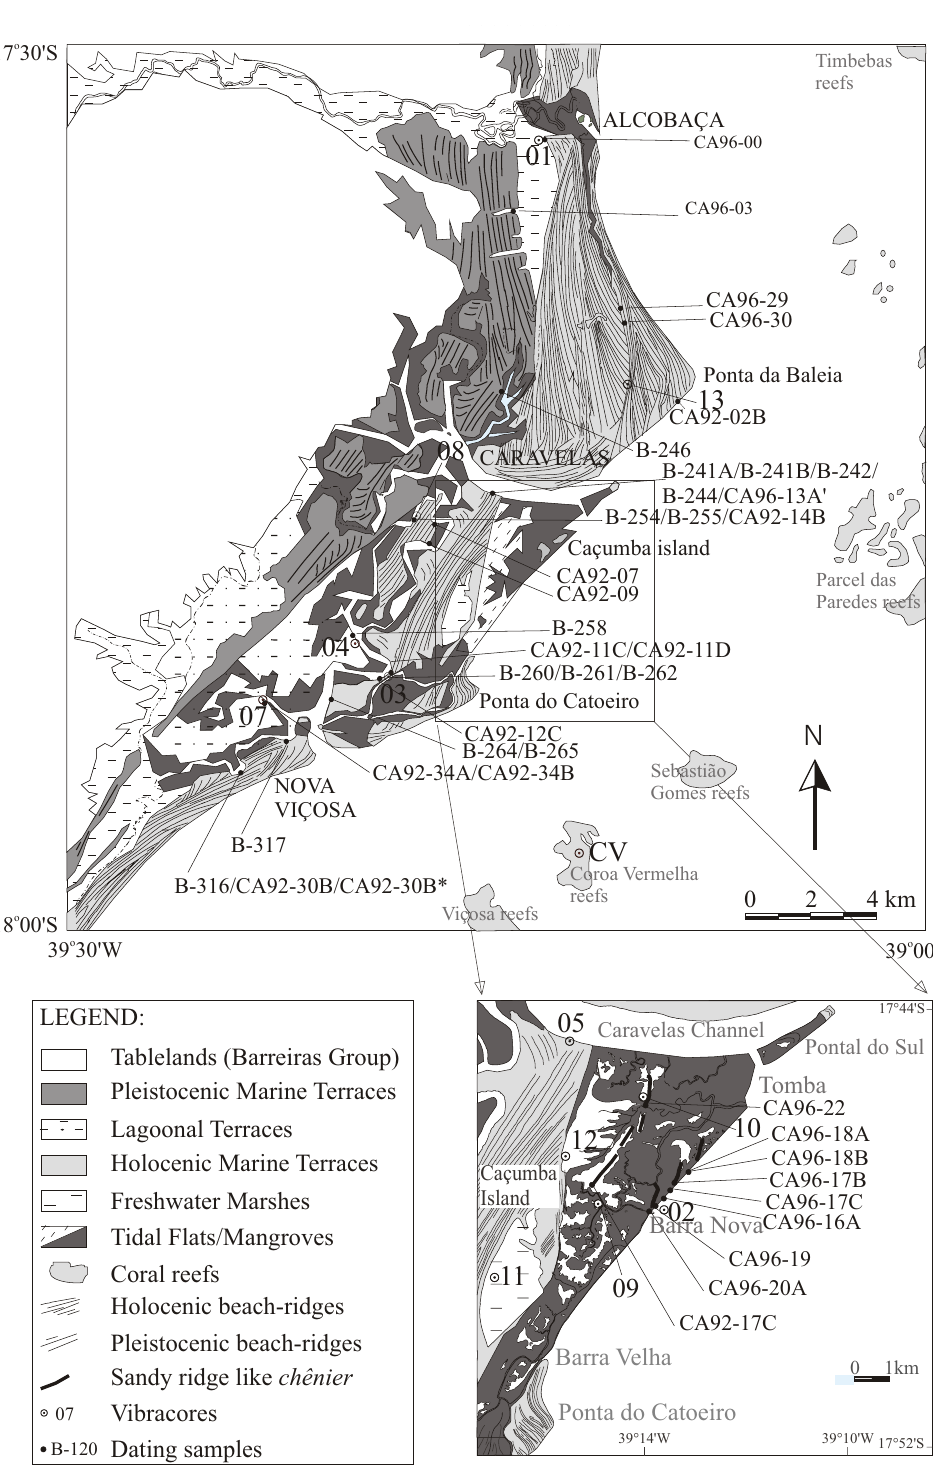
Fig. 5 – Location of vibracores and samples collected in outcrops for radiocarbon